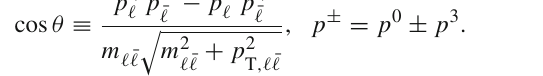
Fig. 1 Neutral-current Drell–Yan production at LO in the quark- antiquark channel